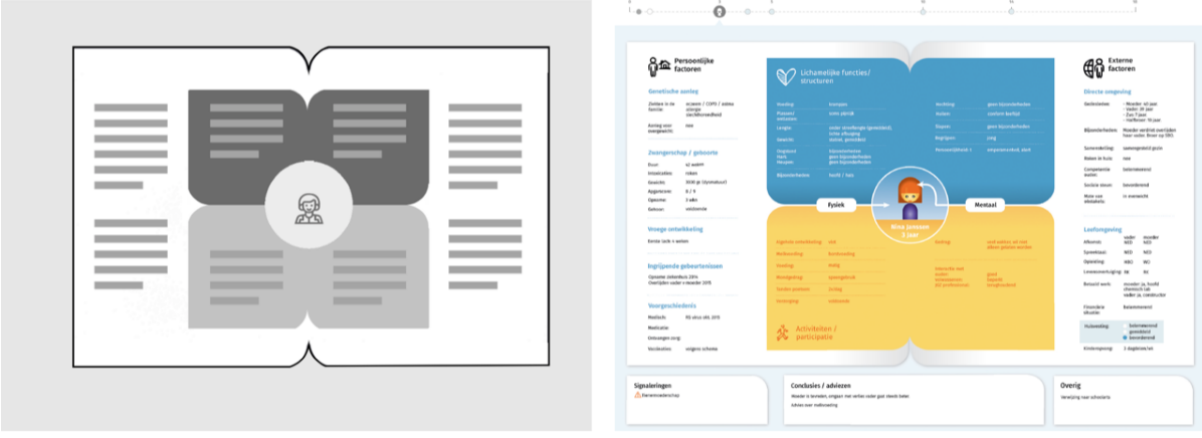
Figure 2. The figures illustrate relevant steps of our iterative design process. The first phase resulted in a global composition design that accurately reflects the content structure (grid layout on the left). In a next step, the design was optimized through additional dimensions such as color, visual language elements such as icons, and illustrations (prototype on the